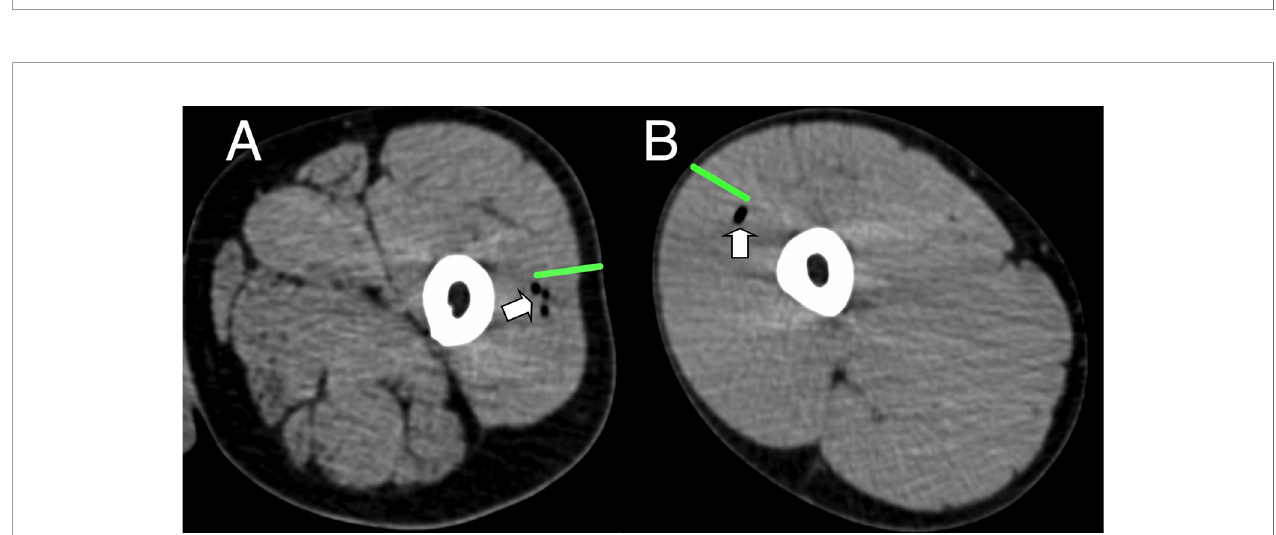
FIGURE 2 | Representative CT imaging of intramuscular immunization site 3 h post injection. Transient inclusions (white arrows) visible at site of immunization with ATIV (A) and 4CMenB (B) . Green bars indicate length of immunization needle, actual injection track